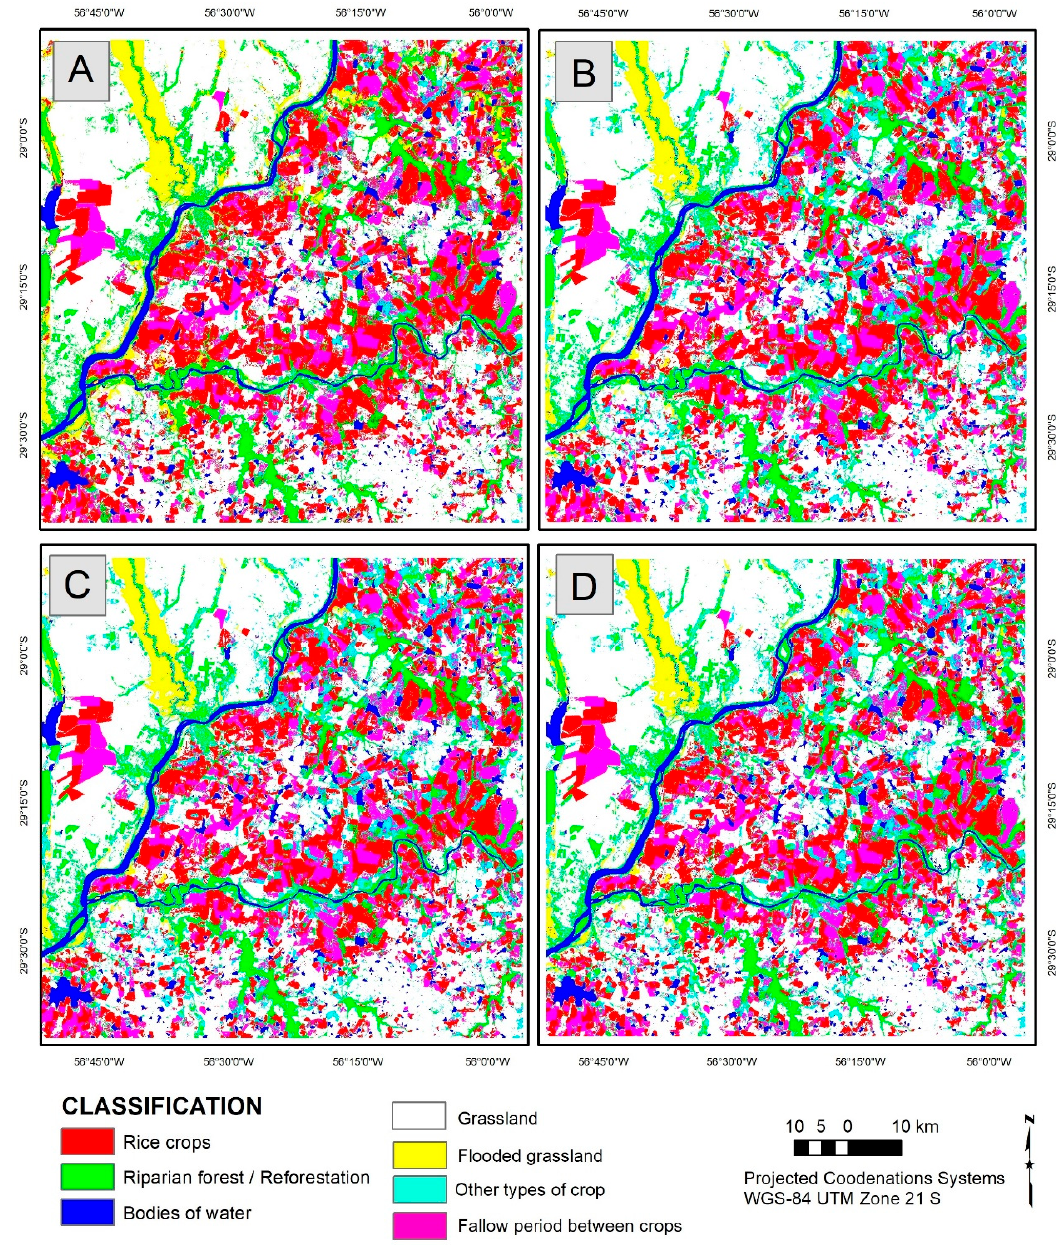
Figure 15. Comparison of classification results within the four best methods in Uruguayan region, located in South Brazil: ( a ) LSTM, ( b ) Bi-LSTM, ( c ) SVM, and ( d ) RF.